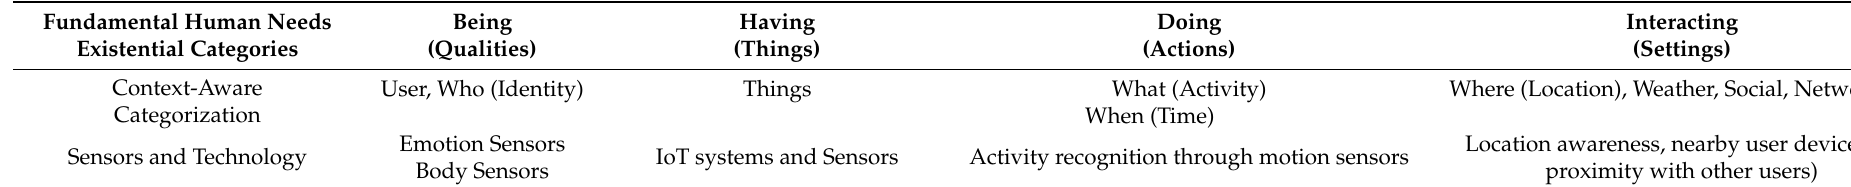
Table 6. Need–context–technology framework